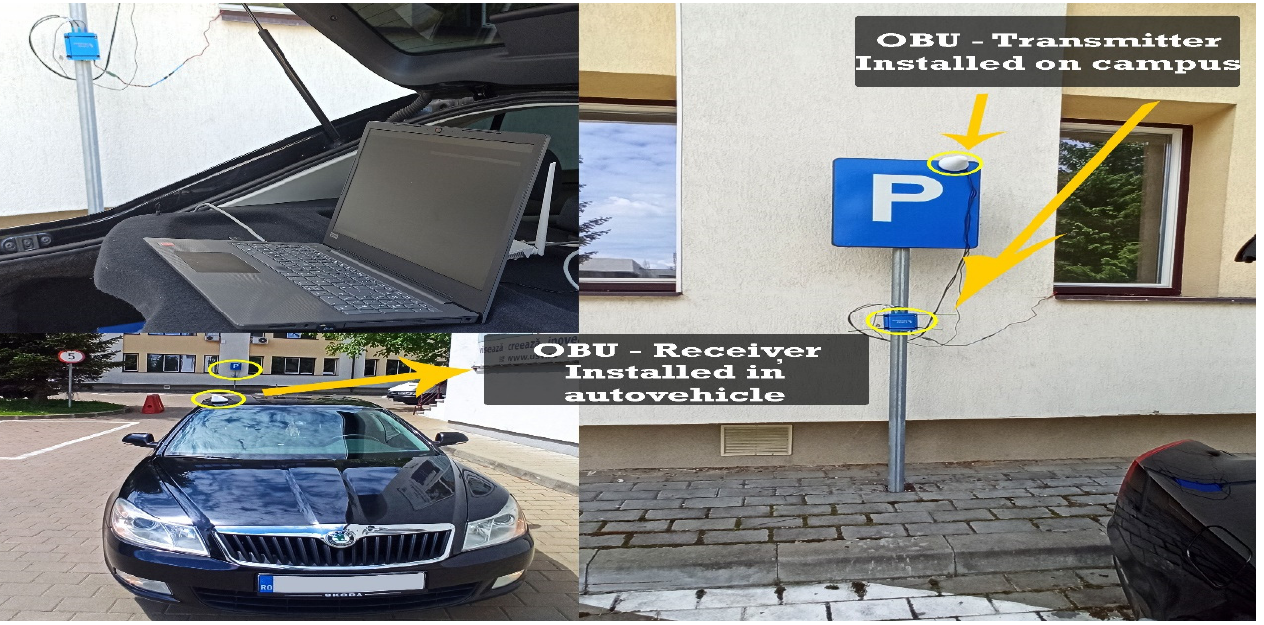
Figure 26. Transmission-reception communication system.